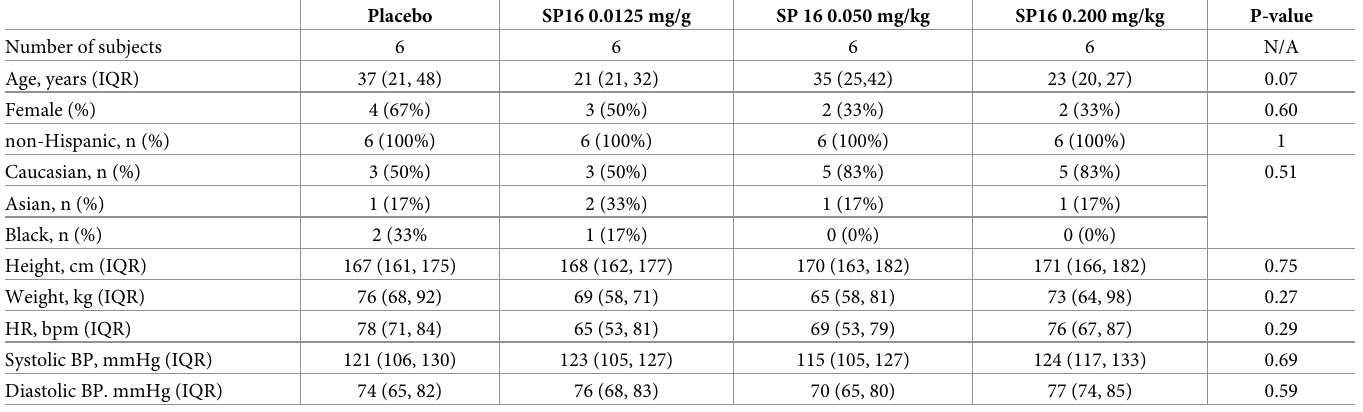
Table 1. Baseline